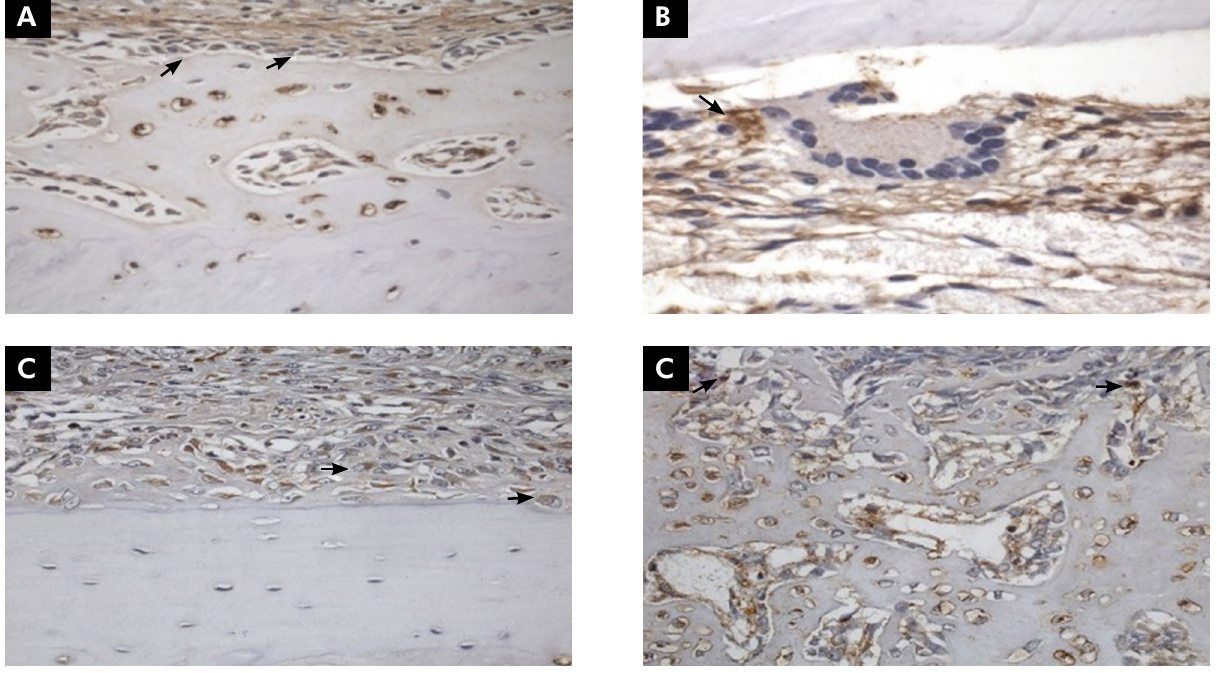
Figure 2. Photomicrographs showing the Rank-L staining a) Day 7 Group OVX-ME: moderate/intense labeling of osteoblasts ( → ) of newly formed bone. x400. b) Day 7 Group OVX-ME: moderate labeling of osteoclast next to the graft. ( → ) x1000. c) Day 7 Group SHAM-ME: moderate/intense labeling of osteoblasts( → ) of newly formed bone. x200 d) Day 7 Group SHAM-ME: moderate/ intense labeling of osteoblasts ( → ) of newly formed bone